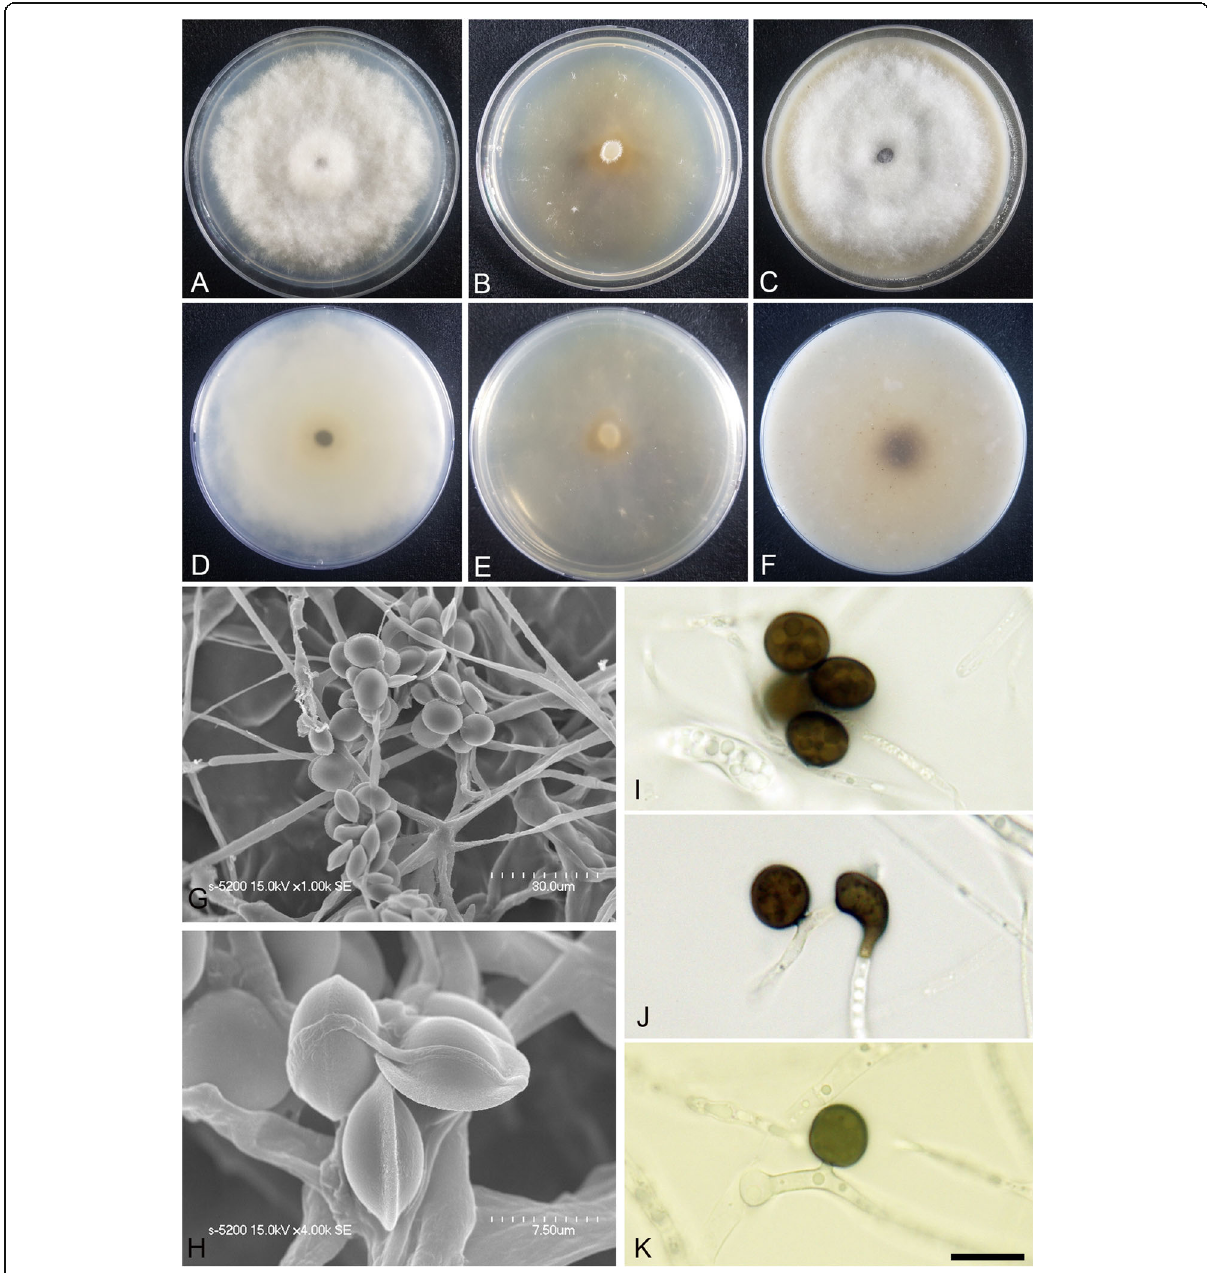
Fig. 4 Arthrinium arctoscopi (KUC21331). a-c Colonies on PDA ( a ), MEA ( b ), and OA ( c ) (top); d-f , colonies on PDA ( d ), MEA ( e ), and OA ( f ) (bottom); g-h , conidia under SEM; I-K, conidia attached to conidiogenous cells; scale bar =10 μ